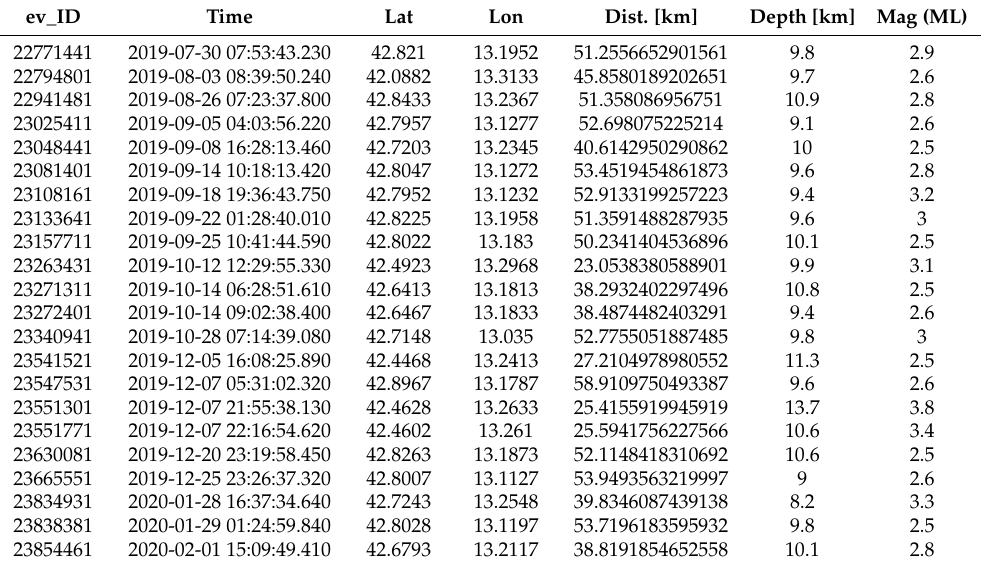
Table 1. List of the events analyzed in this study.